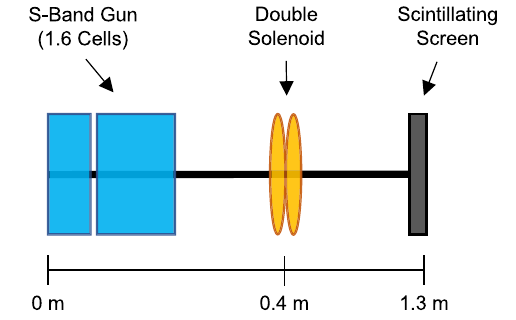
FIG. 1. Schematic of a suitable beamline layout for transverse emittance measurements using the phase advance scan technique. The distances are based on what is installed at the ARES linac at DESY,